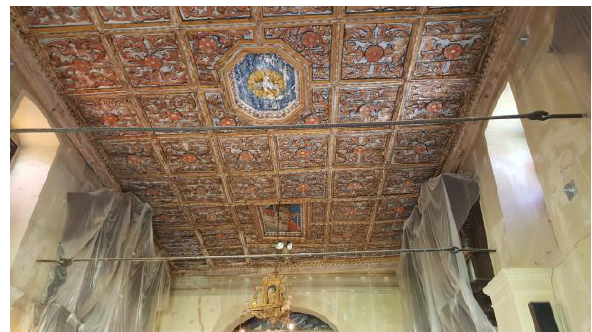
Figure 1. The coffered painted wooden ceiling of the sanctuary of S. Maria delle Grazie church in Varoni (Amatrice - RI), after the 2016 earthquake.